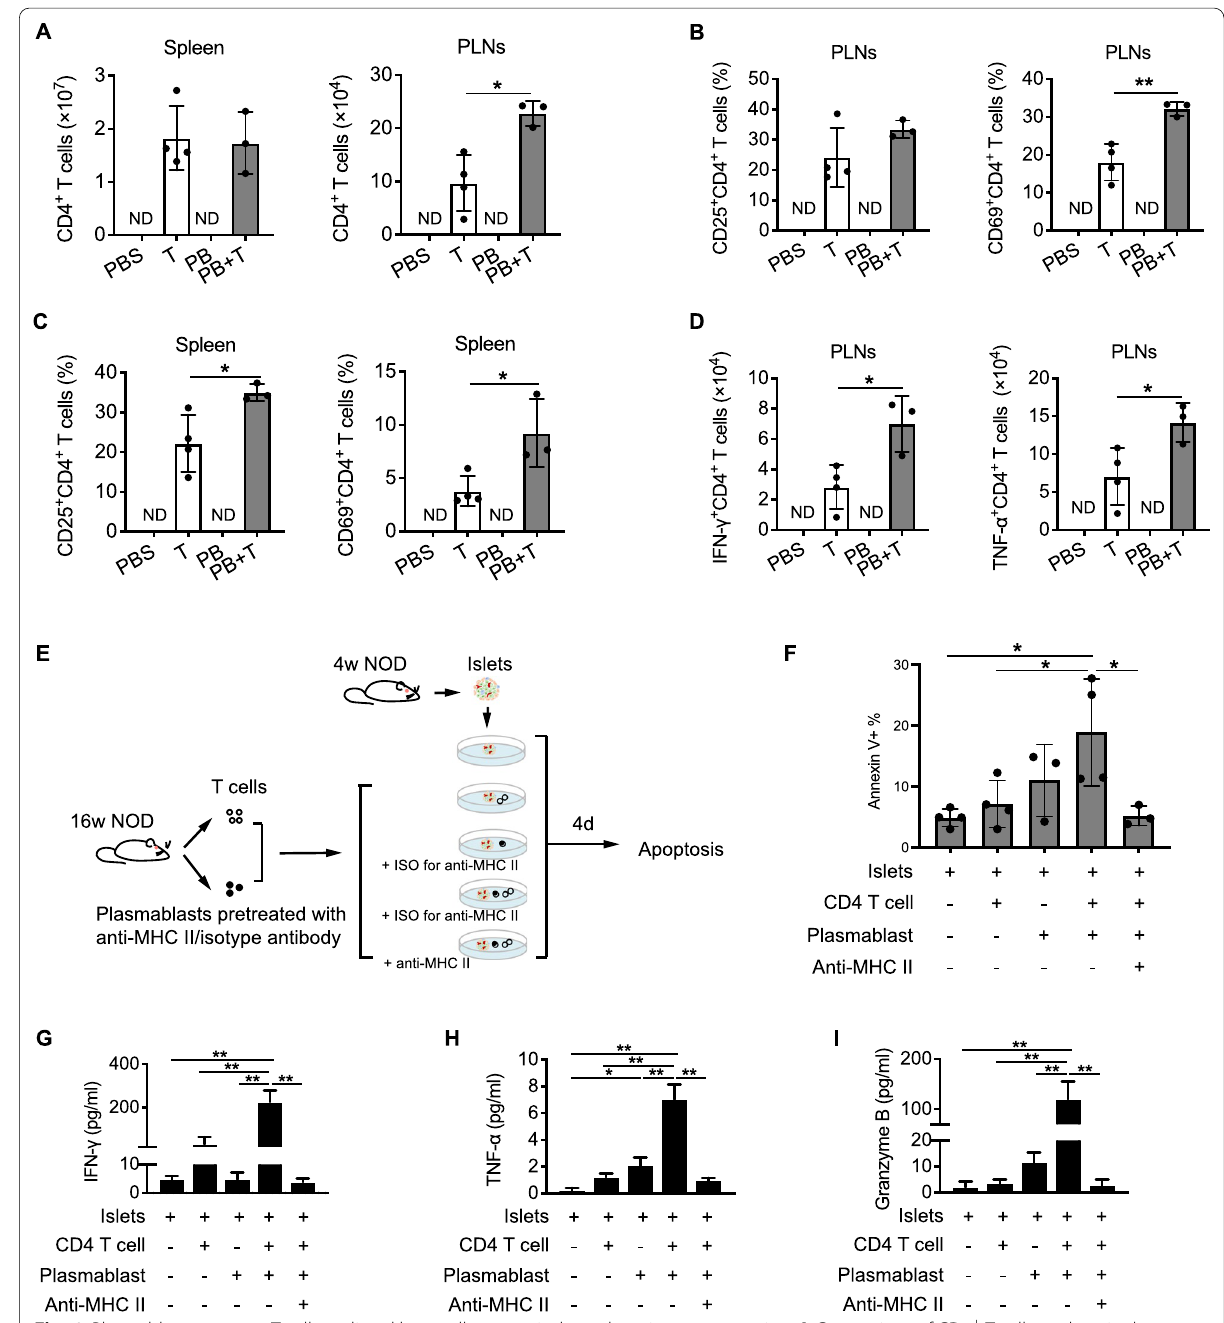
Fig. 6 Plasmablasts promote T cell-mediated beta cell apoptosis through antigen presentation. A Comparison of CD4 + T cell numbers in the spleens and PLNs between PB T group and T group. B – C Comparison of activated CD4 + T cells expressing CD25 or CD69 in the PLNs ( B ) and + spleens ( C ) between PB T group and T group. D Comparison of IFN-γ + CD4 + T cells and TNF-α + CD4 + T cells in the PLNs between PB + and T group. Data indicated mean SD. Difference were analyzed by Independent t test. * P < 0.05, ** P < 0.01. ND indicated not determined. E ± Schematic diagram of the co-culture experiment as described in the methods. F Apoptosis of islet cells in the indicated conditions. G – I Levels of IFN-γ ( G ), TNF-α ( H ), and granzyme B ( I ) in the supernatants of the indicated conditions. Data indicated mean One-way ANOVA followed by Bonferroni’s multiple comparisons test. * P < 0.05, ** P < 0.01. Data indicated mean Tukey’s multiple comparisons test. * P < 0.05, ** P <